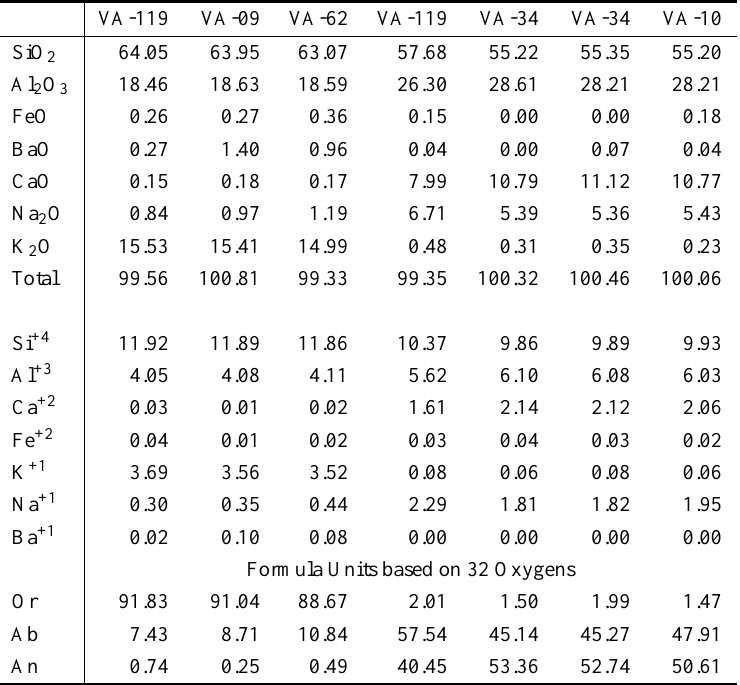
Representative Microprobe analyses of